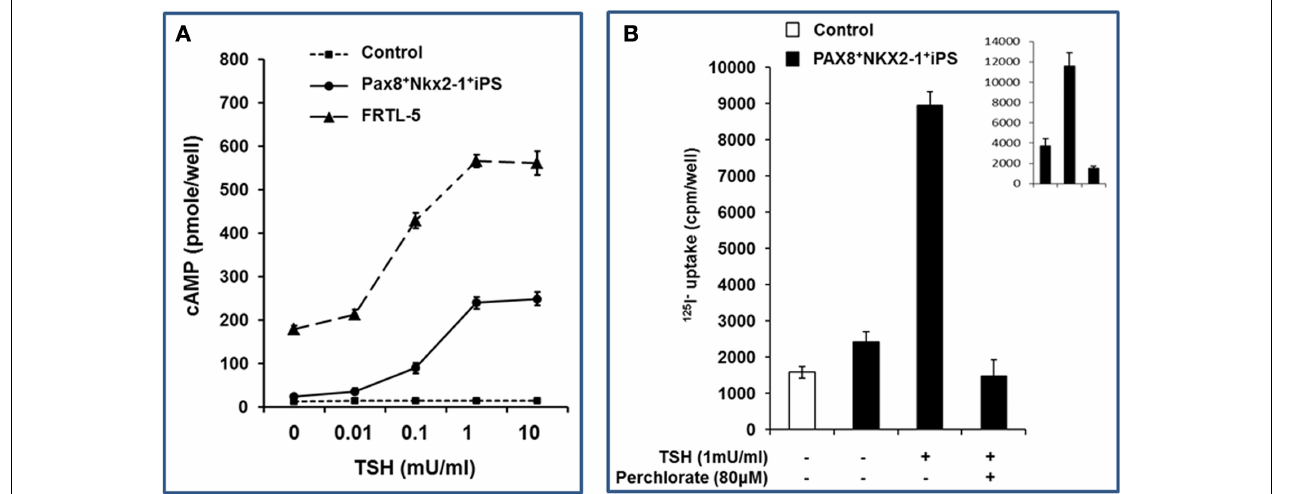
in Section “Materials and Methods”) and the radioactive iodine uptake into the differentiated thyroid cells was measured with and without TSH. Specificity was shown by the use of sodium perchlorate to inhibit the action of NIS and prevent radioactive iodine uptake. The insert is the radioactive iodine uptake in rat thyroid cells, FRTL-5 cell.